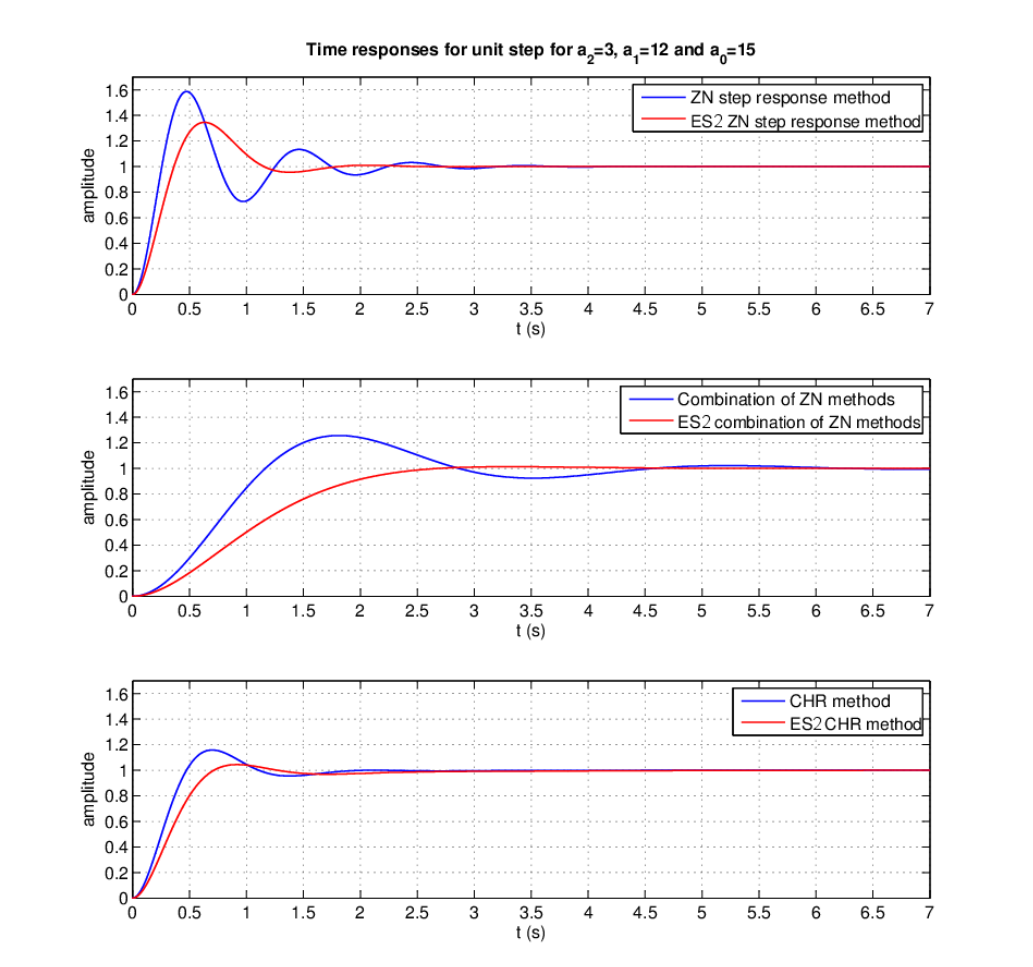
Figure 15. Time responses comparison of the closed feedback loop with a PID controller with parameters determined using the created ES2 and classic appropriate methods for a unit step for a 2 = 3, a 1 = 12 and a 0 = 15